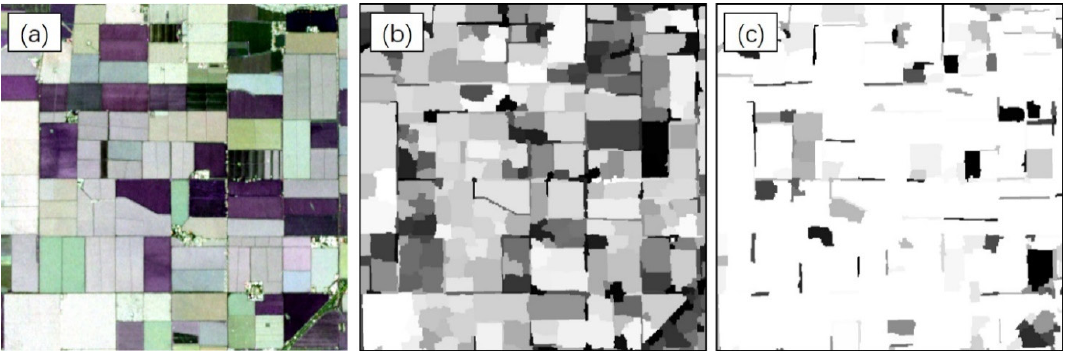
Figure 3. ( a ) A subset of the UAVSAR image (bands VV, HV and HH) used in this paper, ( b ) the prediction probability generated by the OSVM model, ( c ) the prediction probability achieved by the OCNN model. Note that the white objects denote high predictive probability, while dark objects represent low probability.